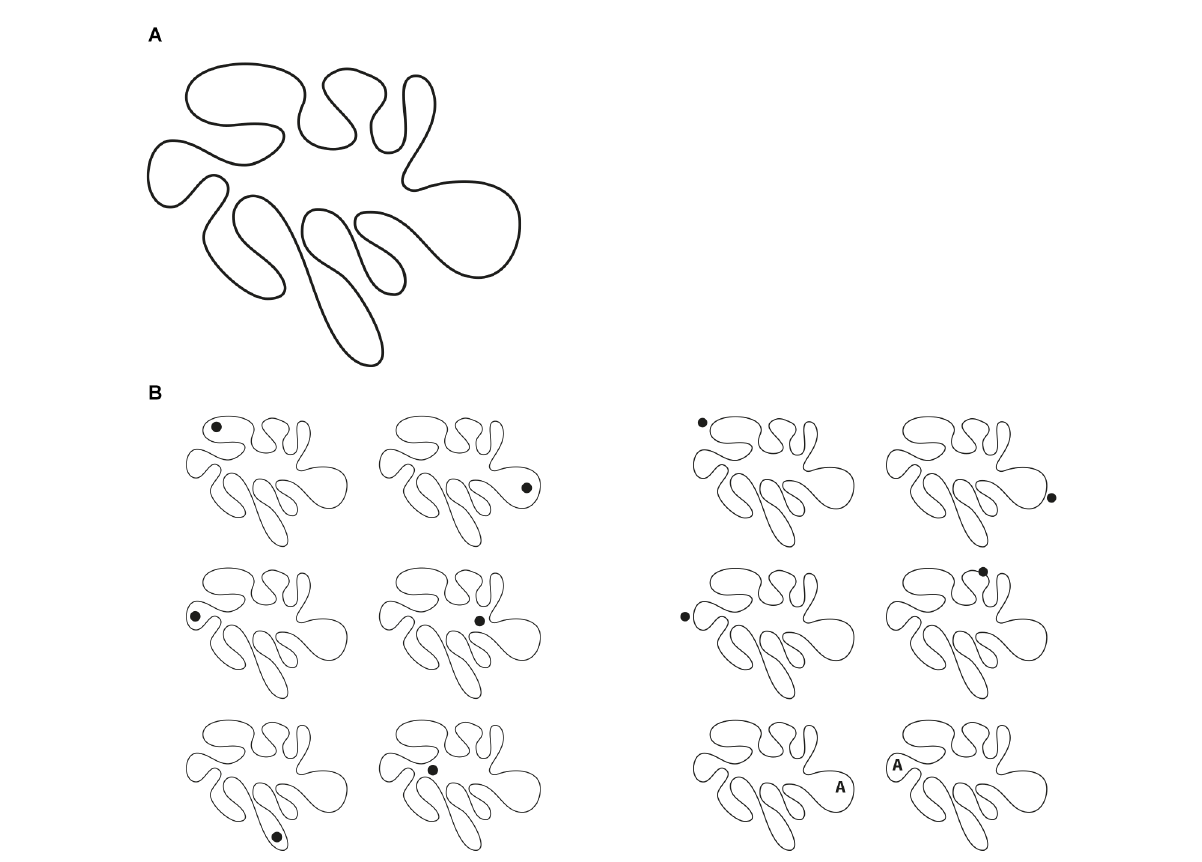
FIGURE14 (A) How many shapes are included within an irregularly undulated shape like this? (B) Different amoeboid organisms with unique expressive attributes, related, for instance, to specific and different species with the precise position of the head, with kinds of legs peculiar to that species that appear as moving along a defined direction, just to mention a few (left). Similar results without the eye effect induced by the dot